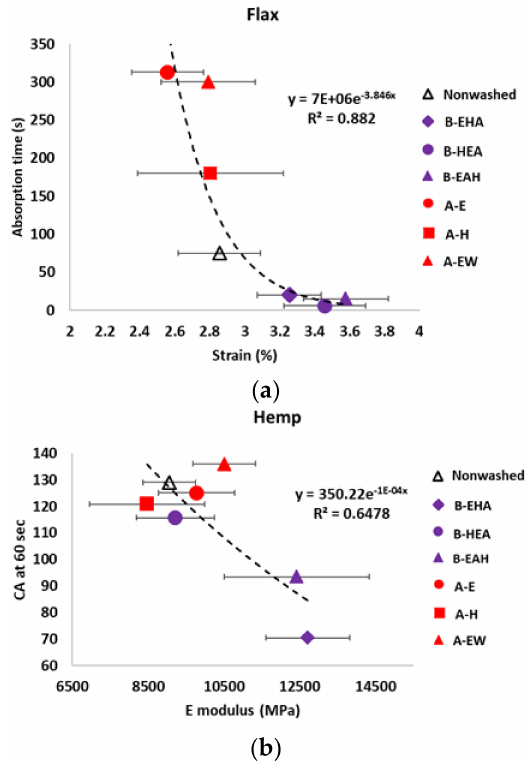
Figure 12. ( a ) The exponential relationship between flax strain capacity and fiber wettability (absorp- tion time); ( b ) the exponential relation between hemp Young’s modulus and fiber wettability (CA at 60 s) (results are presented with standard